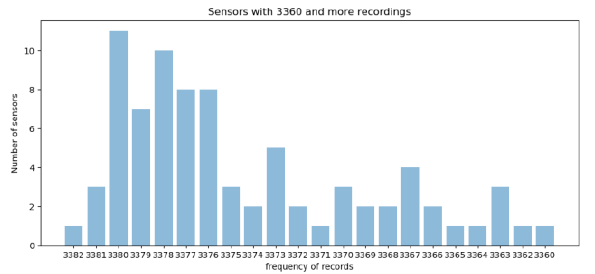
Figure 6. Frequency of recordings